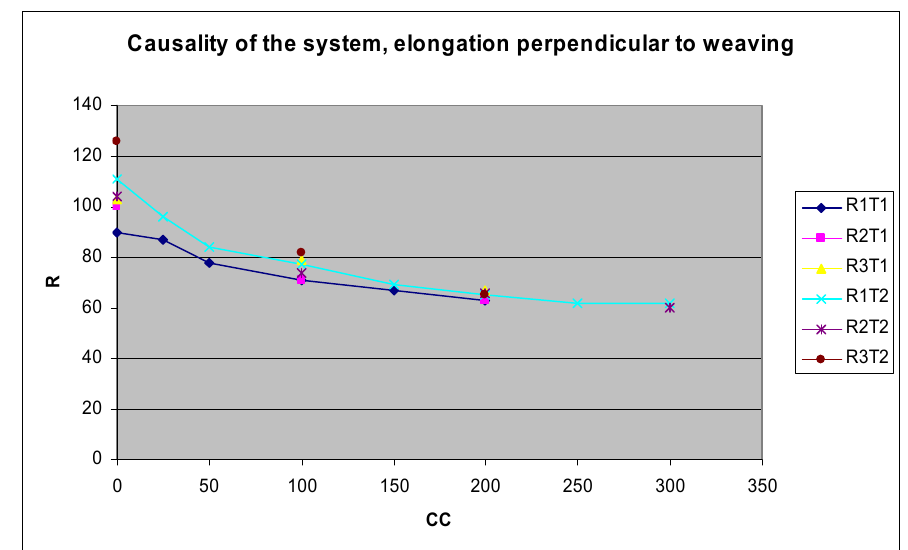
Figure 8. Graphic of the fifth test posed.